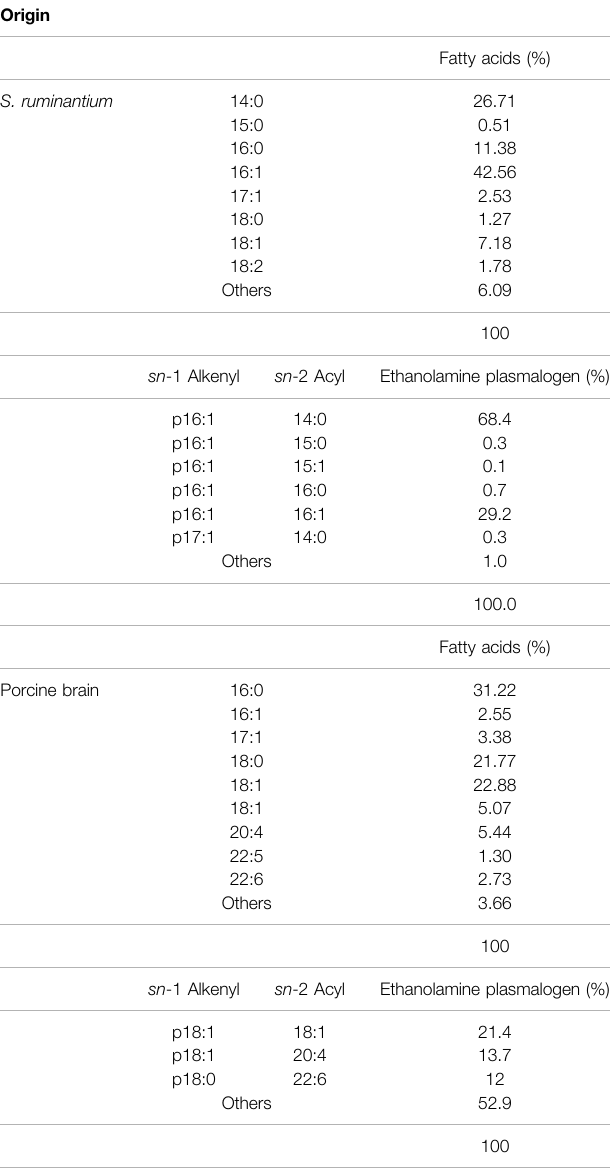
TABLE 2 | The composition of fatty acids in the lipid extracts and molecular species composition in ethanolamine plasmalogen of lipid extracts from Selenomonas ruminantium and porcine brain.